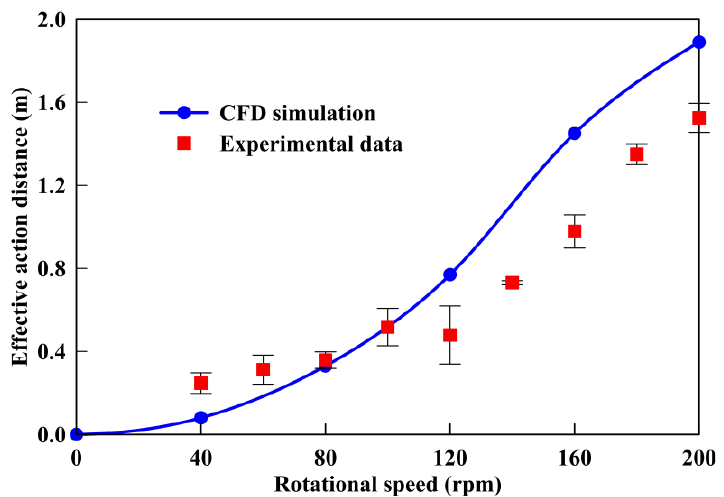
Figure 15. Comparison between simulated and experimented effective action distance.